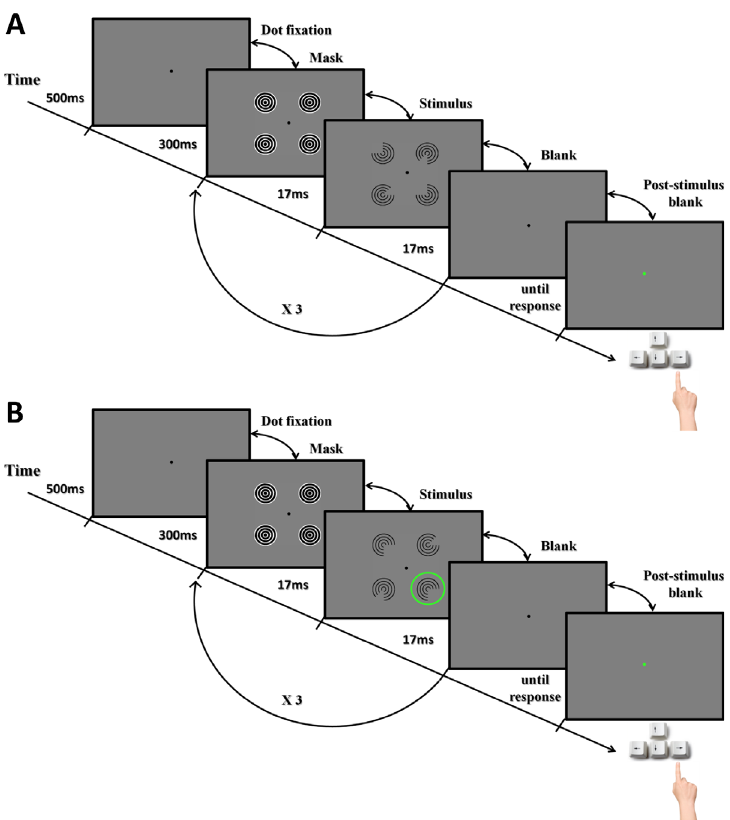
Fig 2. Illustration of the trial sequence in experiment 1. A) Kanizsa task: Each trial was composed of five frames: fixation dot, mask, stimulus, blank, and post-stimulus blank. After the participant ’ s response, the fixation point provided feedback for 100ms (green: correct; red: incorrect). The duration of each frame is shown on the time-line. Note that in the visible conditions, a blank screen replaced the mask. B) Visibility task: Trials proceeded in the same way as in the Kanizsa task except that only control stimuli were being shown and participants judged whether the right-angle gap was in the bottom left or right inducer (indicated by the green circle, which was not present in the actual